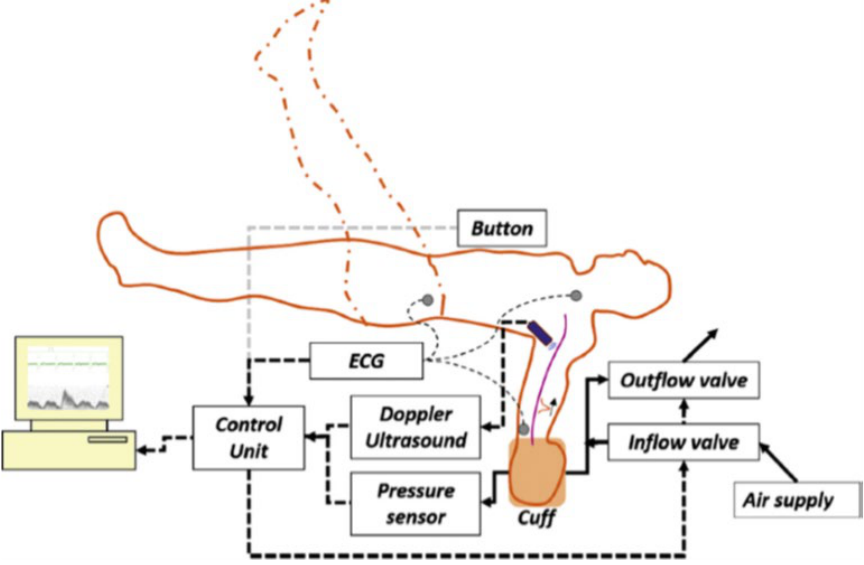
Figure 11. Set-up to estimate vPWV